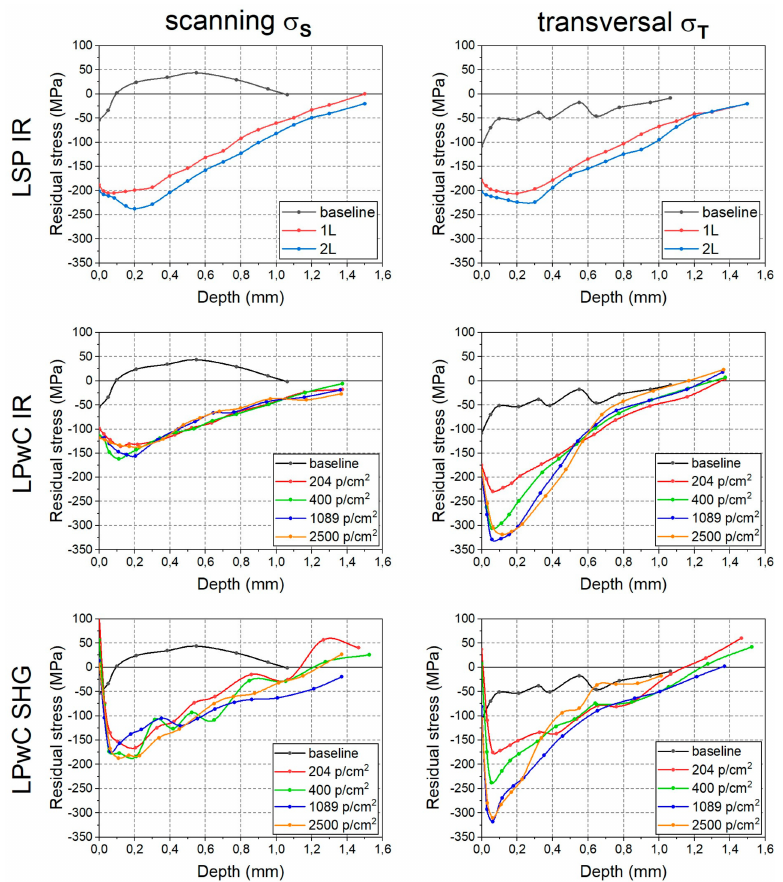
Figure 6. XRD residual stress measurements of selected peening setups (rows) in scanning σ S and transversal σ T direction